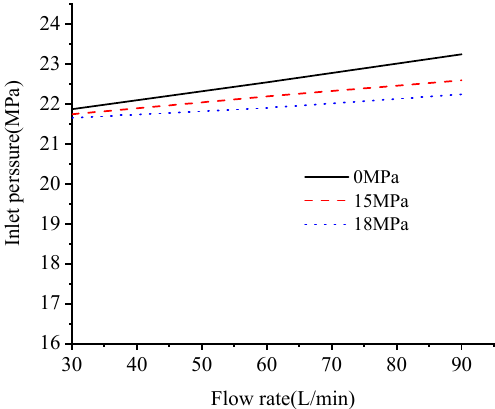
Figure 26. Pressure regulating deviation test curve of the relief valve.